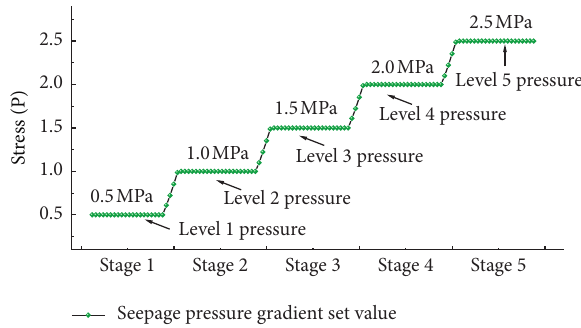
Figure 4: Schematic diagram of seepage pressure